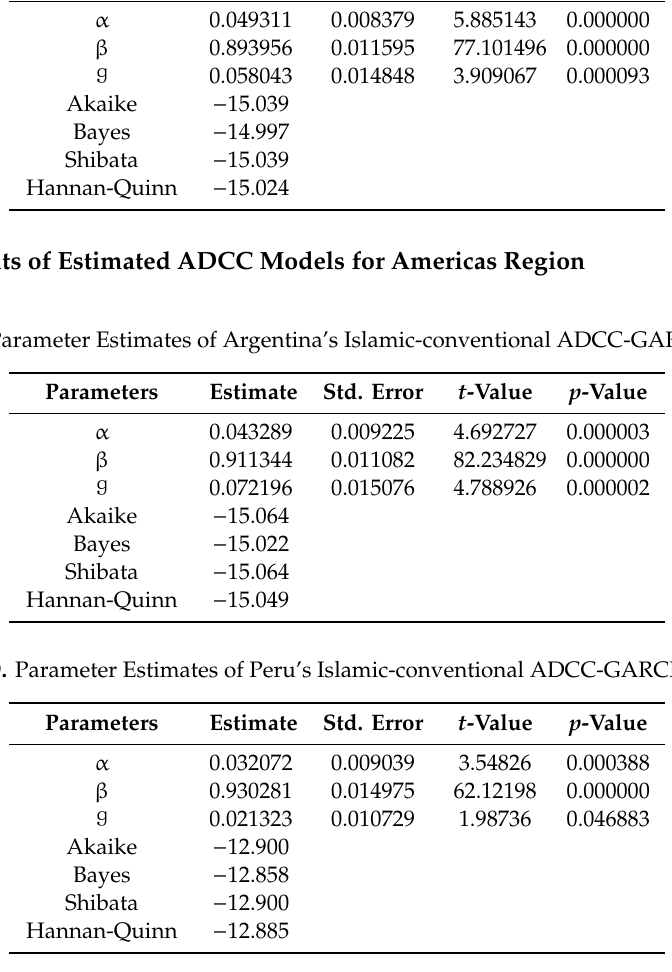
Table A3. Parameter Estimates of China’s Islamic-conventional ADCC-GARCH model.